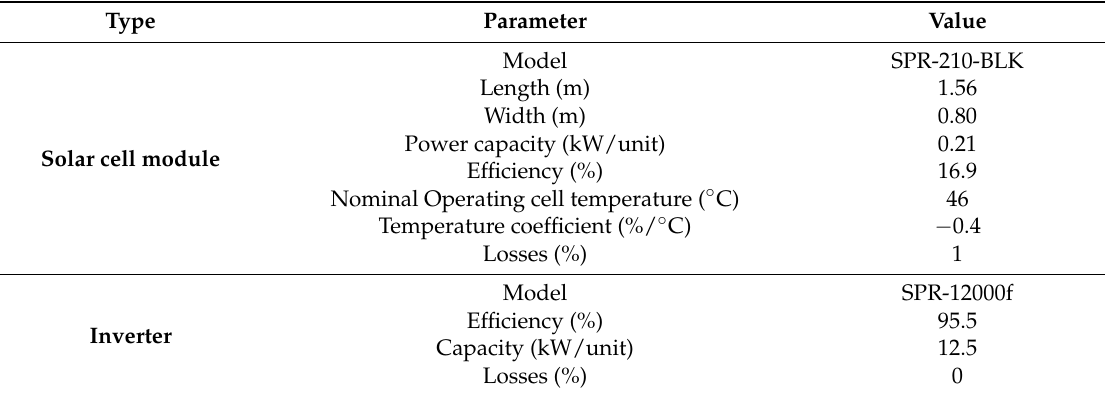
Table 1. Design parameters for the photovoltaic systems considered in this